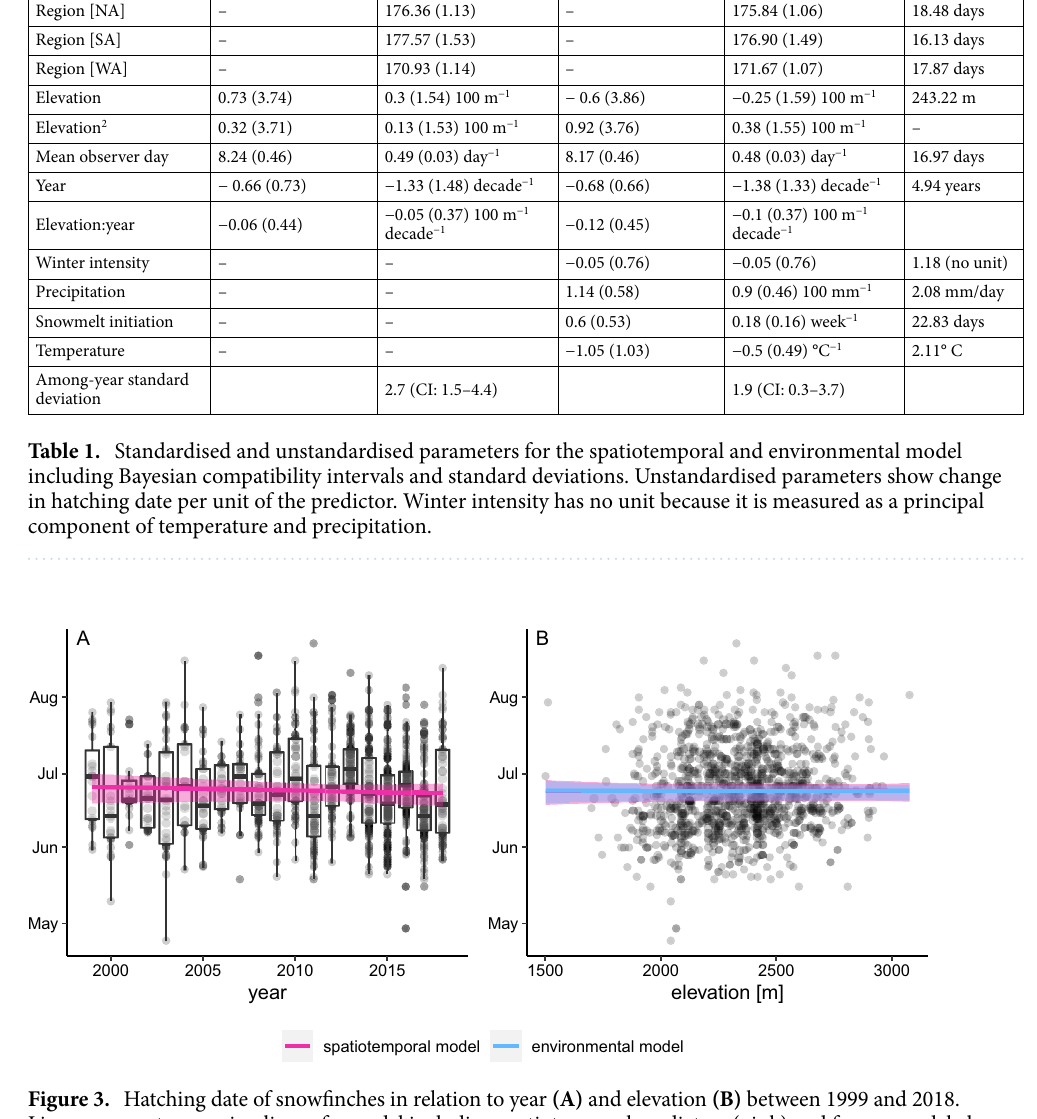
Figure 3. Hatching date of snowfinches in relation to year (A) and elevation (B) between 1999 and 2018. Lines represent regression lines of a model including spatiotemporal predictors (pink) and from a model also including environmental predictors (blue). Polygons show Bayesian 95% compatibility intervals accordingly. In (A) , we only show the regression line for the spatiotemporal model because the regression lines of the two models were essentially